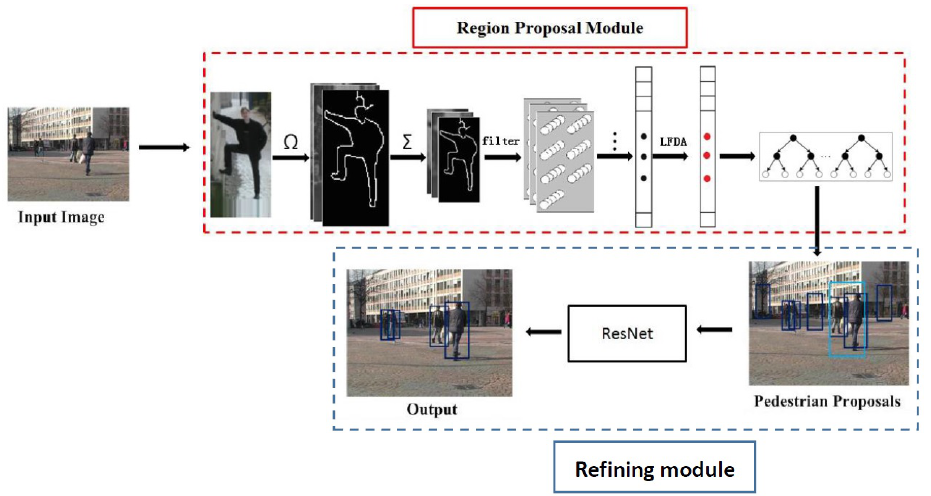
Figure 2. The flowchart of SDFF for pedestrian detection.